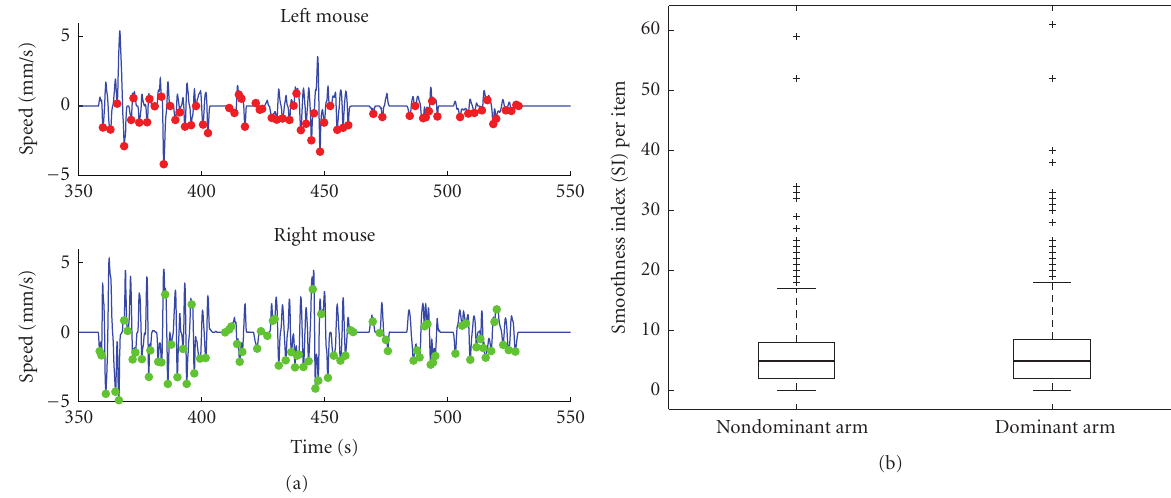
Figure 6: Analysis of movement smoothness by means of the Smoothness Index (SI). (a) Sample speed profiles of the movements tracked by both NTT mice. The number of movement segments contained in a specific movement trajectory is computed by locating the speed local minima (red and green dots). (b) SI is computed for each arm and for each item collected in the virtual training environment. Boxplot from 10 healthy participants. For more information see text.